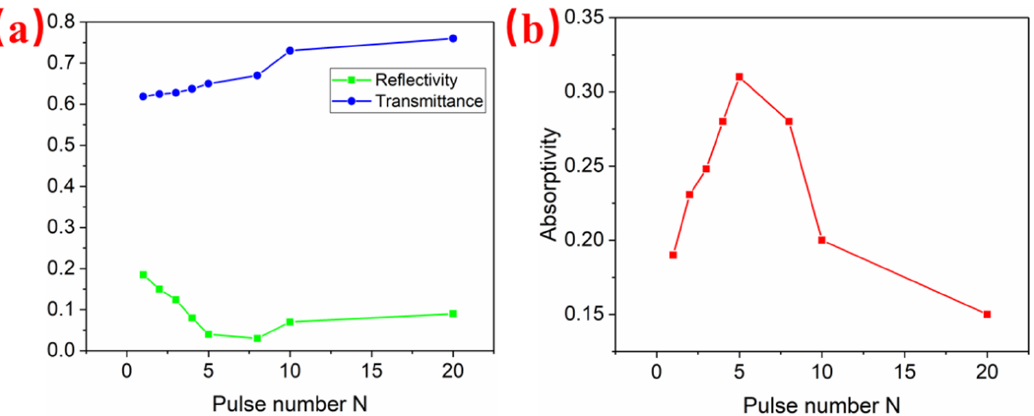
Figure 4. Measured ( a ) reflectance, transmittance and ( b ) absorptance of the ITO film for each consecutive femtosecond laser pulse. The pulse fluence was fixed at 0.66 J/cm 2 .